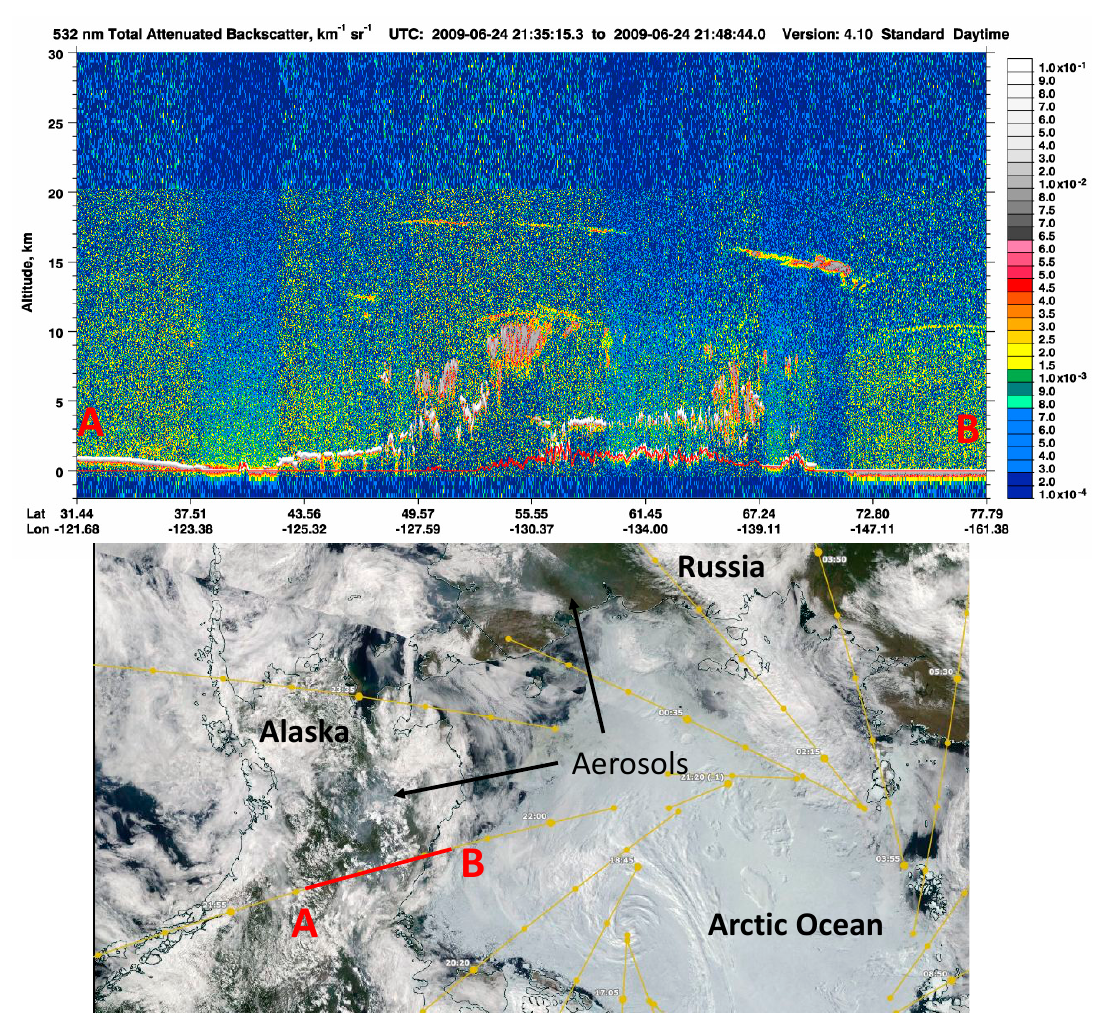
Figure 5. ( Top ): CALIPSO lidar profiles acquired at UTC 21:35:15 on 24 June 2009, over the Beaufort Sea where a high (14–18 km) aerosol layer spans ~2000 km. This aerosol layer occurred in the vicinity of MISR-observed stratospheric aerosol plumes at approximately the same time. ( Bottom ): Hazy aerosol layers can be seen elsewhere over the Arctic in the MODIS